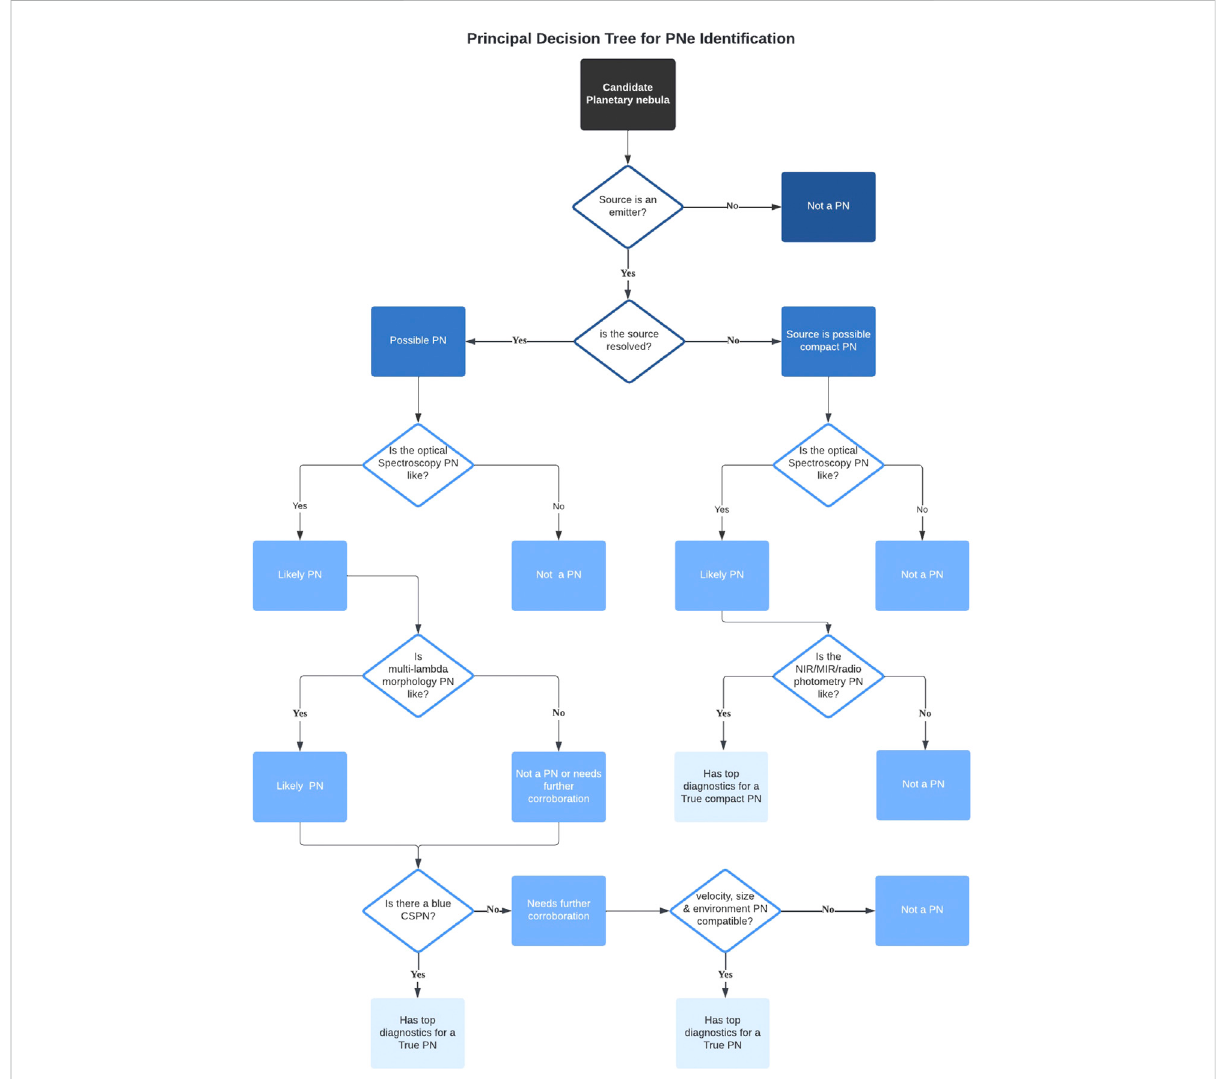
FIGURE 11 Principal HASH PN identi fi cation decision tree in the form of a basic fl ow-chart split into two main branches depending on whether the candidate is resolved or compact in available imagery. This chart satis fi es most eventualities when good data is available for all key diagnostics. For cases where the data is not clear cut and/or evidence is contradictory, further corroboration is needed and candidates are then classed as likely or possible PNe if there are no clear grounds for complete rejection (see main